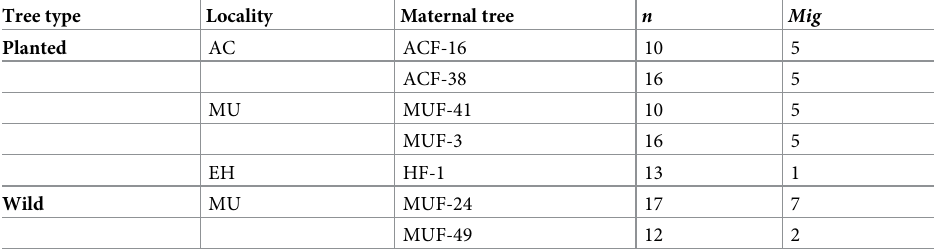
Table 4. Progeny arrays with multilocus identical genotypes to maternal trees, from wild and planted trees of Spondias purpurea .